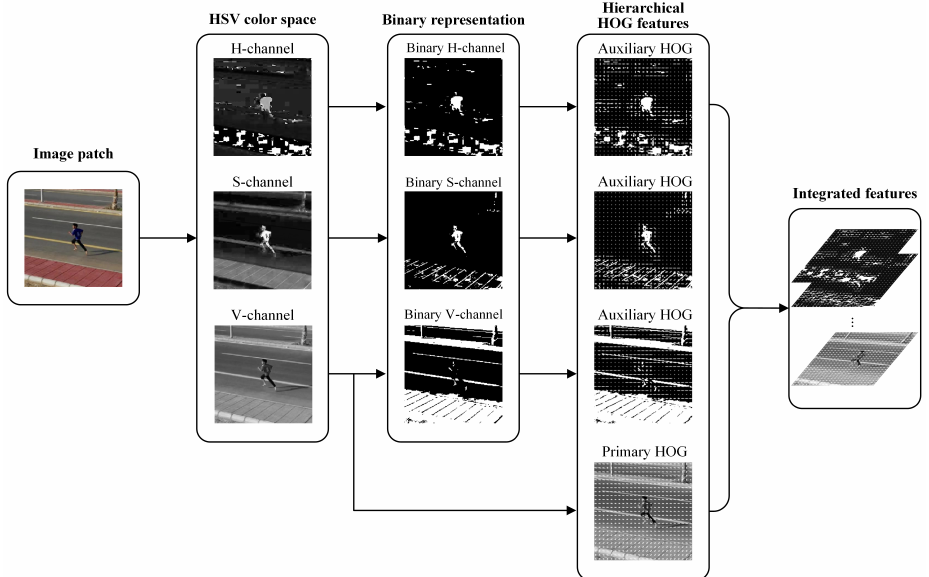
Figure 2. Illustration of the feature integration